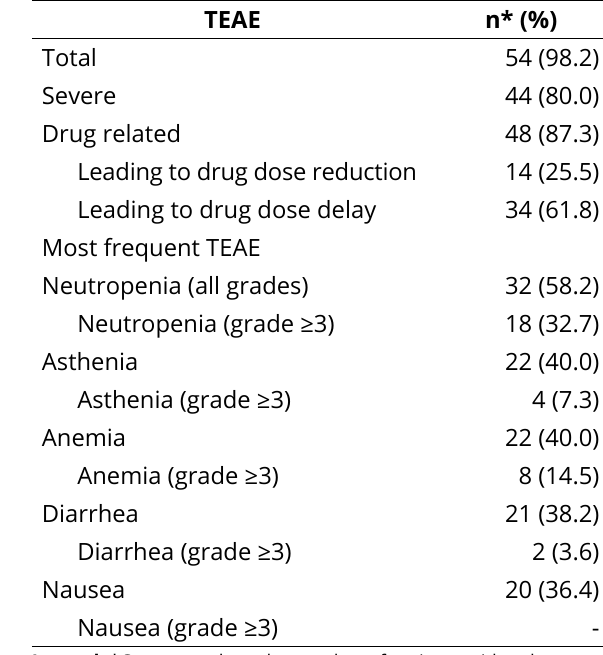
Table 3. Treatment Emergent Adverse Effect